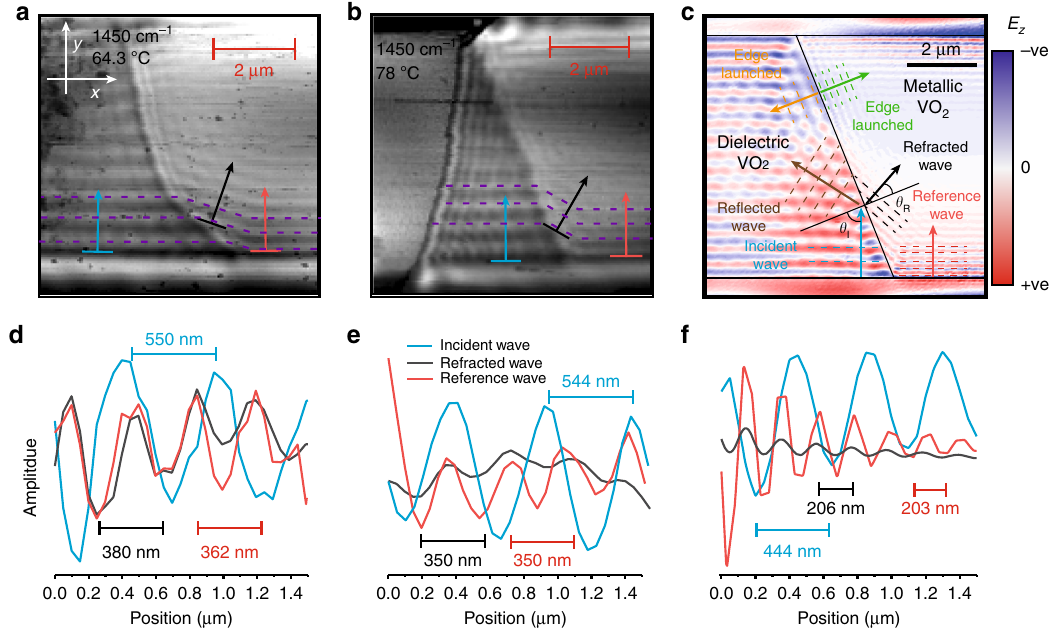
Fig. 2 Hyperbolic polariton refraction within a hBN-VO 2 heterostructure. a , b Two s-SNOM maps of the near- fi eld amplitude in the region of the domain boundary showing refraction. Purple dashed lines show the distorted phase front that propagates over the boundary. c An electromagnetic- fi eld simulation of the geometry in b , showing re fl ected, refracted and edge-launched waves. d – f Line pro fi les from a to c , respectively, showing refraction of the